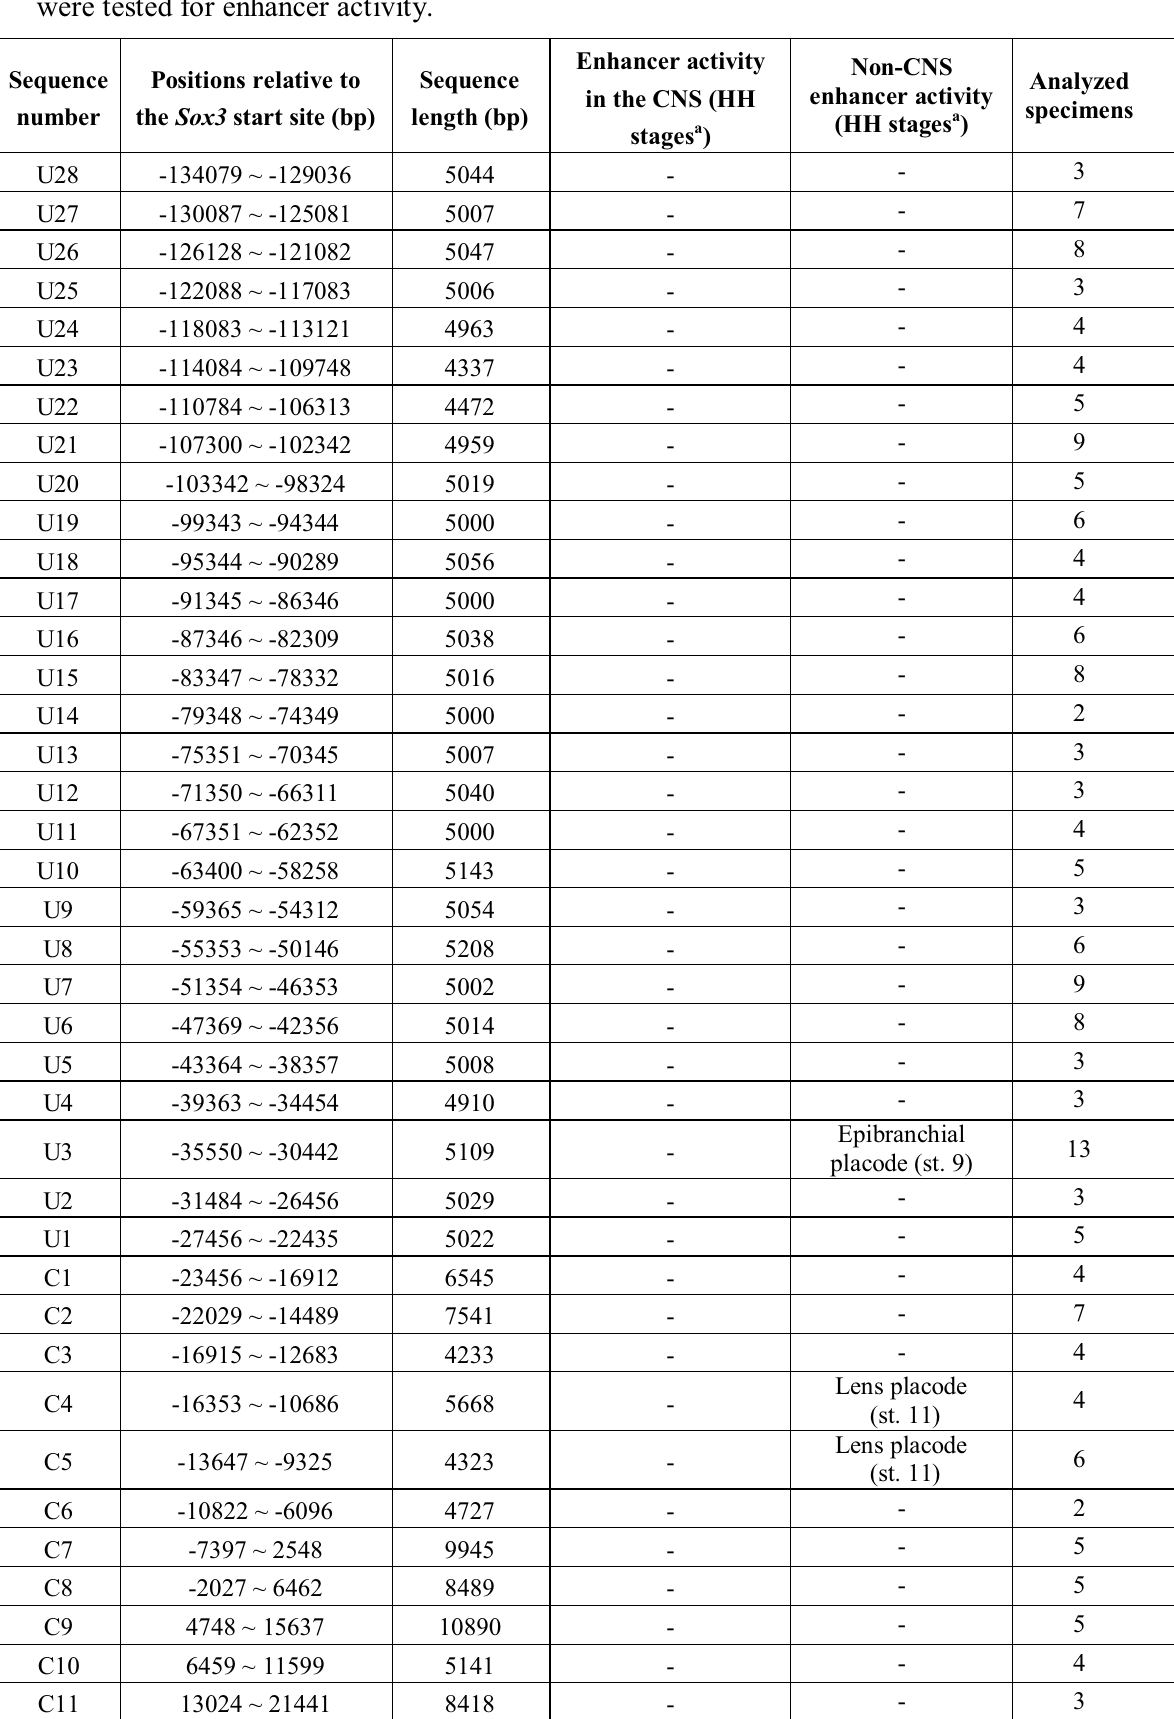
Table S2. Positioning of the DNA sequences relative to the Sox3 ORF start site, which were tested for enhancer